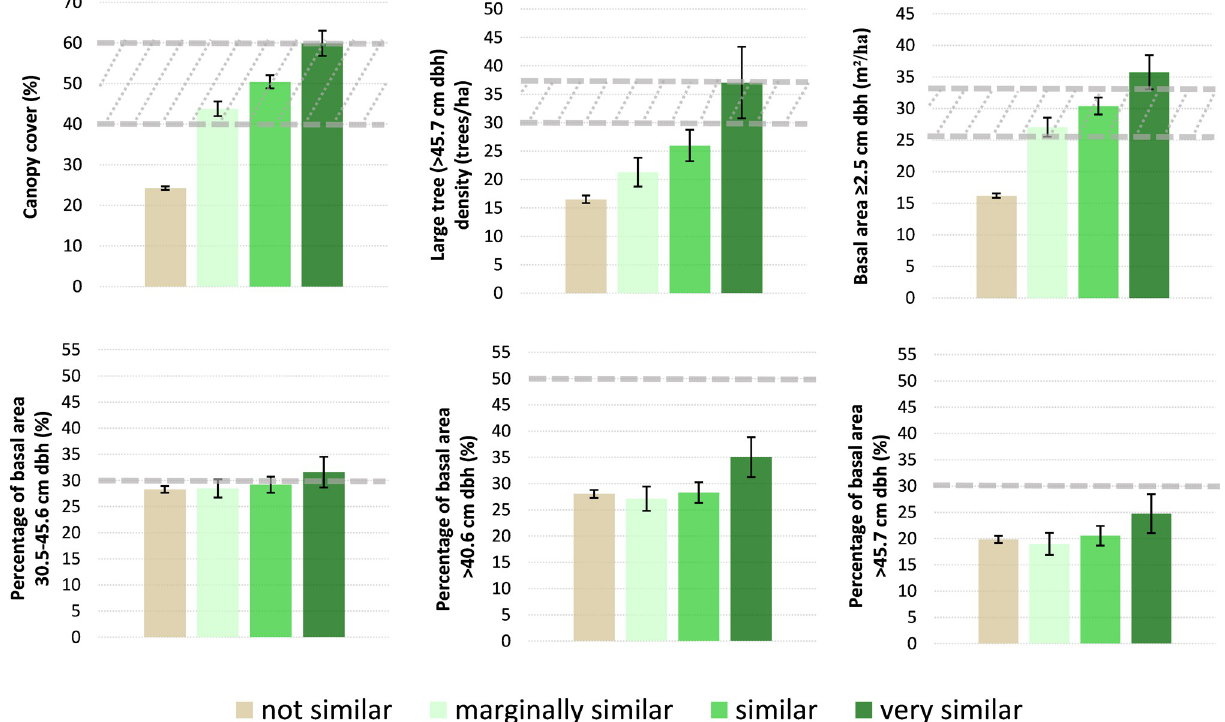
Fig 3. Forest structural attributes of cover type spectral similarity map classes. Dashed gray lines represent minimum desired conditions from Table 1. Height of bars represents mean and 95% confidence intervals are shown in error bars.